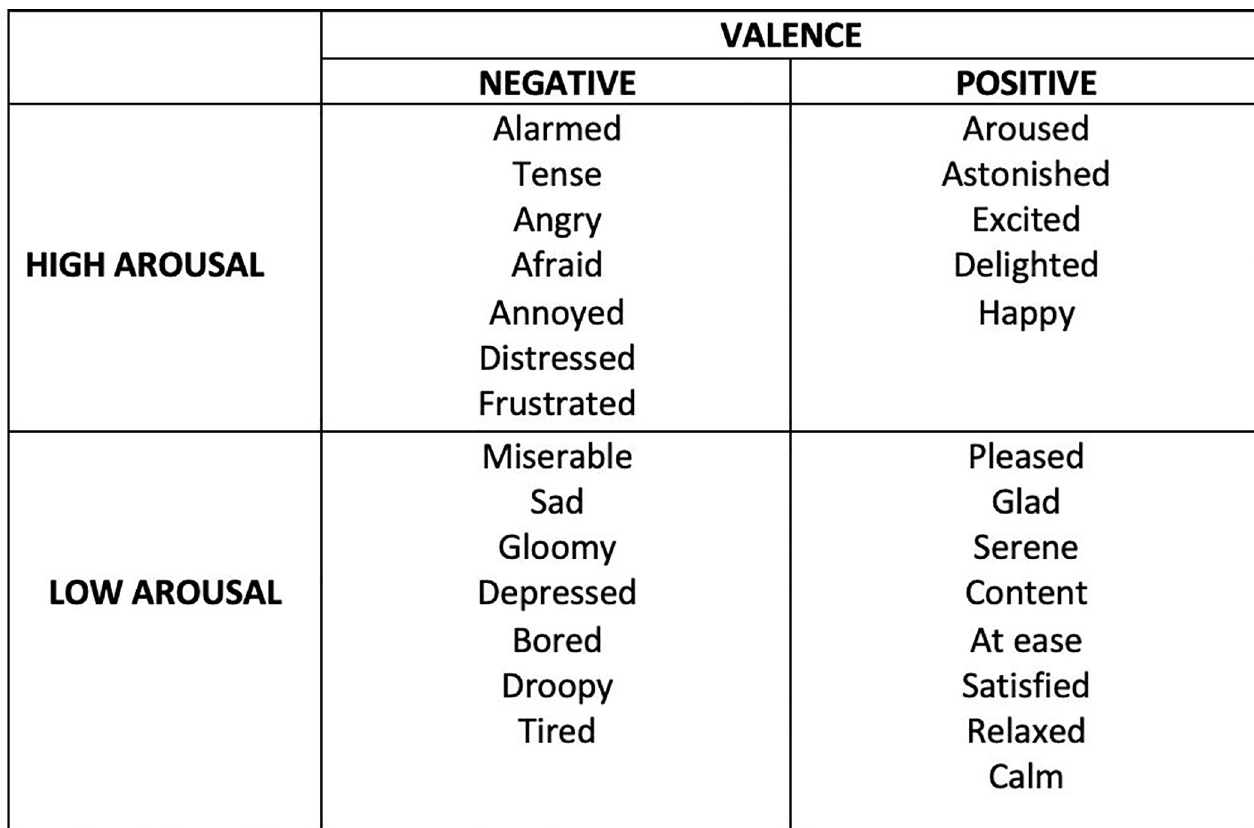
Fig 1. The four categories in the circumplex model and complete list of